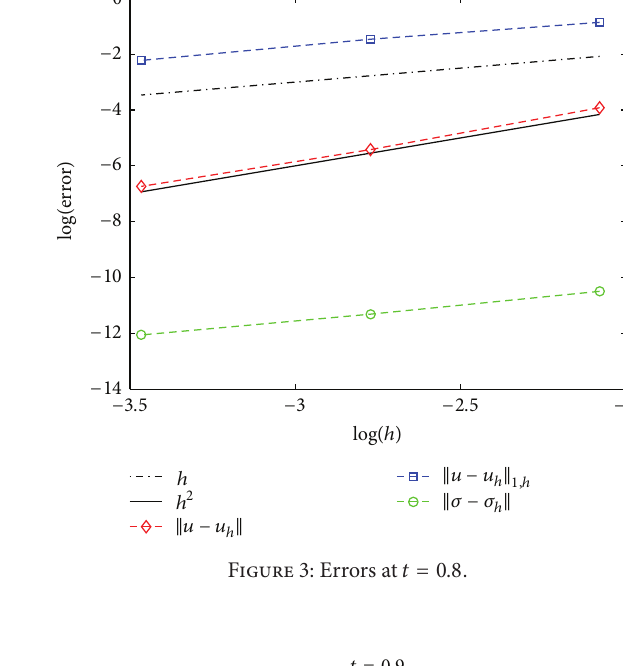
Figure 1: Errors at 𝑡 = 0.4 .